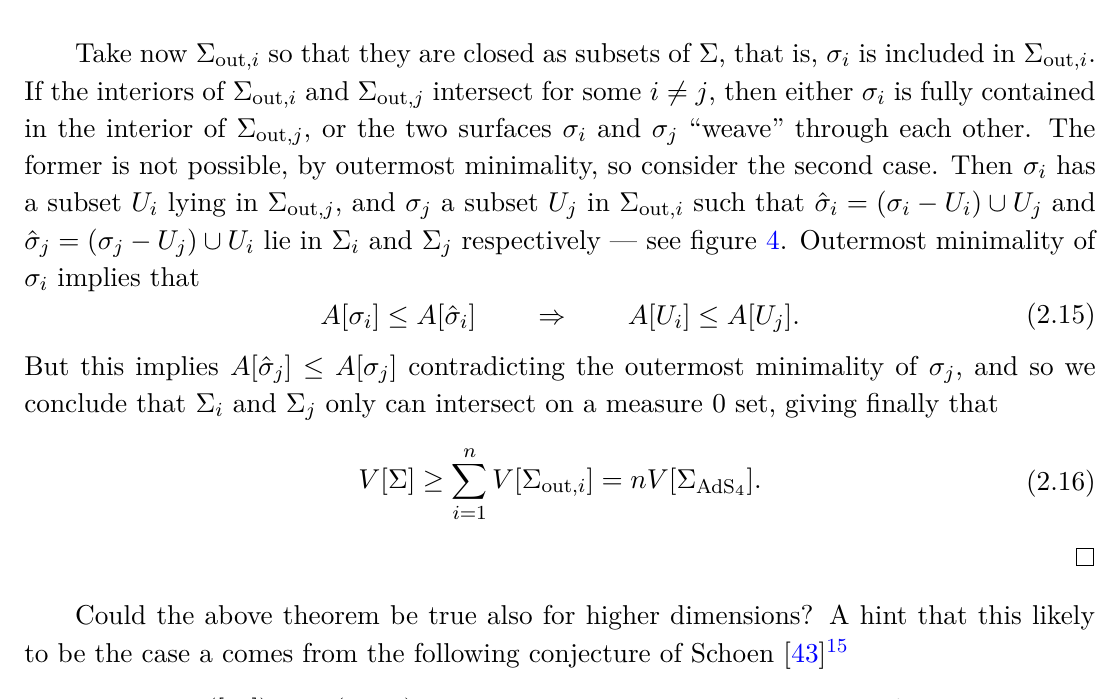
) ∪ U would have area less than σ i − U i j j